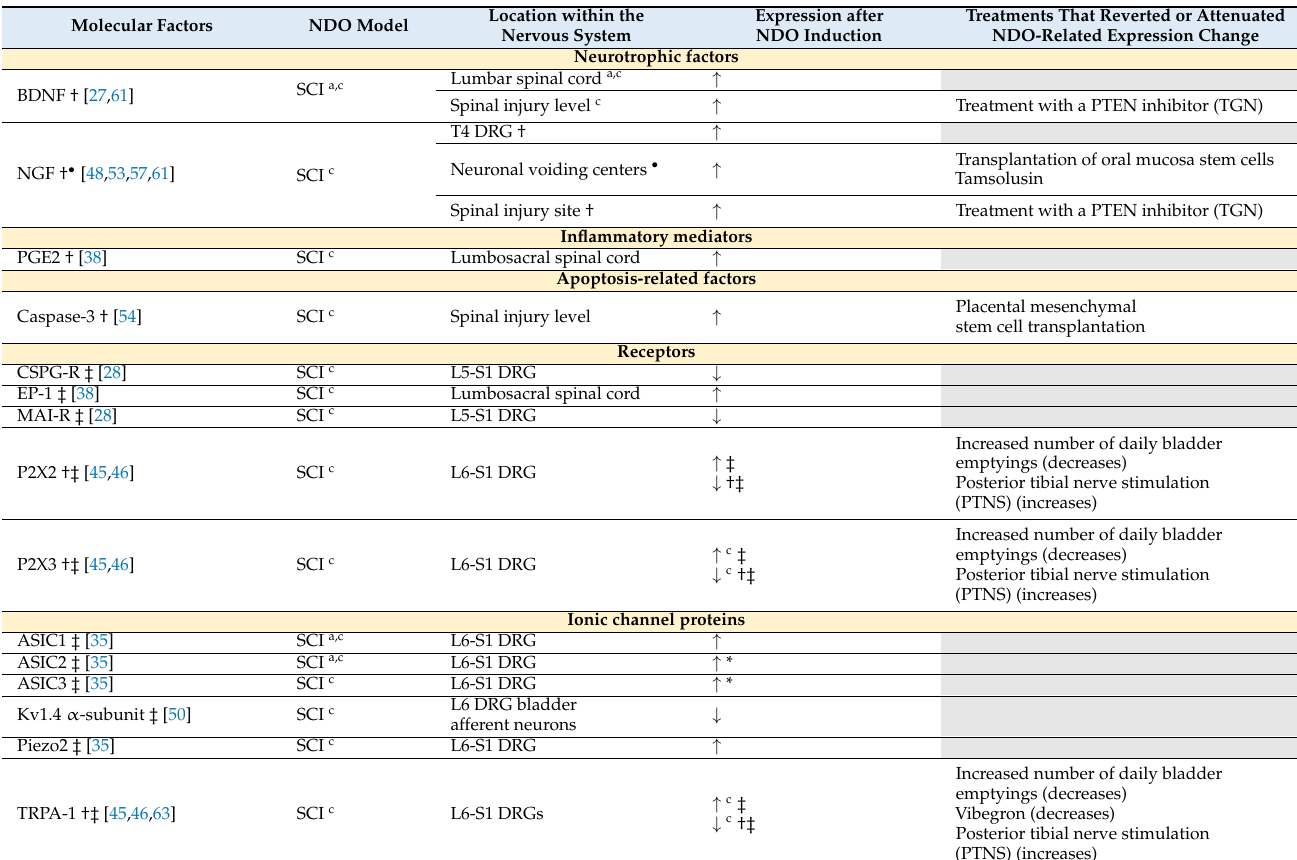
Table 3. Expression of molecular markers in the nervous system (NS) after NDO induction according to NDO model and NS site. Every molecule with a statistically significant expression variation ( p < 0.05) in the included papers is present in this table. Molecules are split into categories and ordered alphabetically. BDNF: brain-derived neurotrophic factor, GAP-43: growth-associated pro- tein 43, NGF: nerve growth factor, IFN- γ : interferon-gamma, IL: interleukin, PGE2: prostaglandin E 2 , TNF- α : tumor necrosis factor alpha, CSPG-R: chondroitin sulfate proteoglycans receptors, EP: prostaglandin E 2 receptor, MAI-R: myelin-associated inhibitors receptors, ASIC: acid-sensing ion channel, Kv1.4 α -subunit: voltage-activated Shaker-related potassium channel 1.4 alpha-subunit, TRPA-1: transient receptor potential ankyrin-1, TRPV-1: transient receptor potential vanilloid-1, 5-HT: 5-hydrxytryptamine, CGRP: calcitonin gene-related peptide, CRF: corticotropic-releasing factor, GAD2: glutamic acid decarboxylase, NF200: neurofilament 200, TH: tyrosine hydroxylase, VAChT: vesicular acetylcholine transporter, VGLUT-2: vesicular glutamate transporter 2, VEGF- α : vascular endothelial growth factor-alpha, MAG: myelin-associated glycoprotein, MBP: myelin basic protein, OMgp: oligodendrocyte-myelin glycoprotein, RGMa: repulsive guidance molecule A, ATF-3: cyclic AMP-dependent transcription factor-3, GFAP: glial fibrillary acidic protein, iNOS: inducible nitric ox- ide synthase, LC3-II: microtubule-associated protein 1A/1B-light chain 3-phosphatidylethanolamine conjugate, NADPH-d: dihydronicotinamide adenine dinucleotide phosphate diaphorase, pJNK: